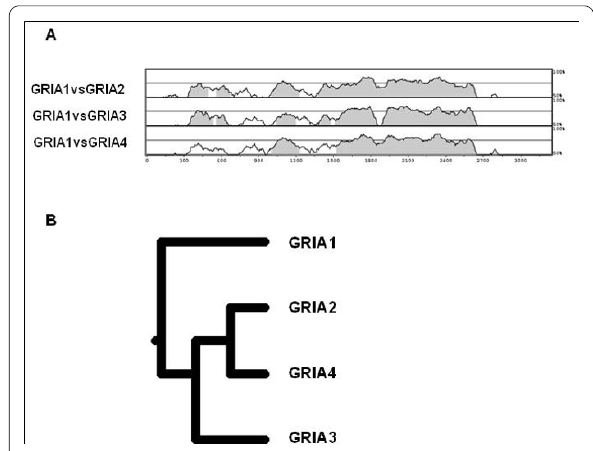
Figure 4 Comparative analysis of GRIA1-GRIA4 genes . A: compari- son of GRIA1 coding region versus GRIA2 , GRIA3 and GRIA4 cDNAs. B: phylogenetic